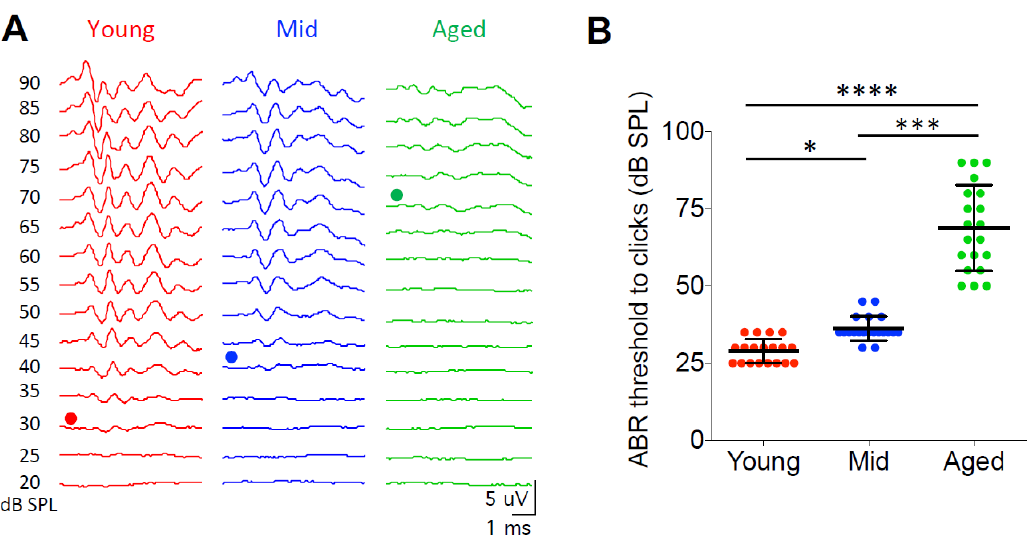
Figure 1. Auditory brainstem responses reveal age-related hearing loss in CBA / CaJ mice. ( A ) Representative auditory brainstem response (ABR) waveforms from mice in three age groups in response to clicks. Dots mark the traces at hearing threshold. ( B ) Summary ABR thresholds from all mice. Kruskal–Wallis test: * p < 0.05; *** p < 0.001; **** p < 0.0001. Individual data points are shown along with mean ± S.D. for each group.